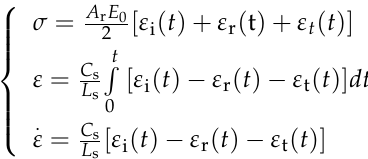
Figure 4. The LT-SHPB system.